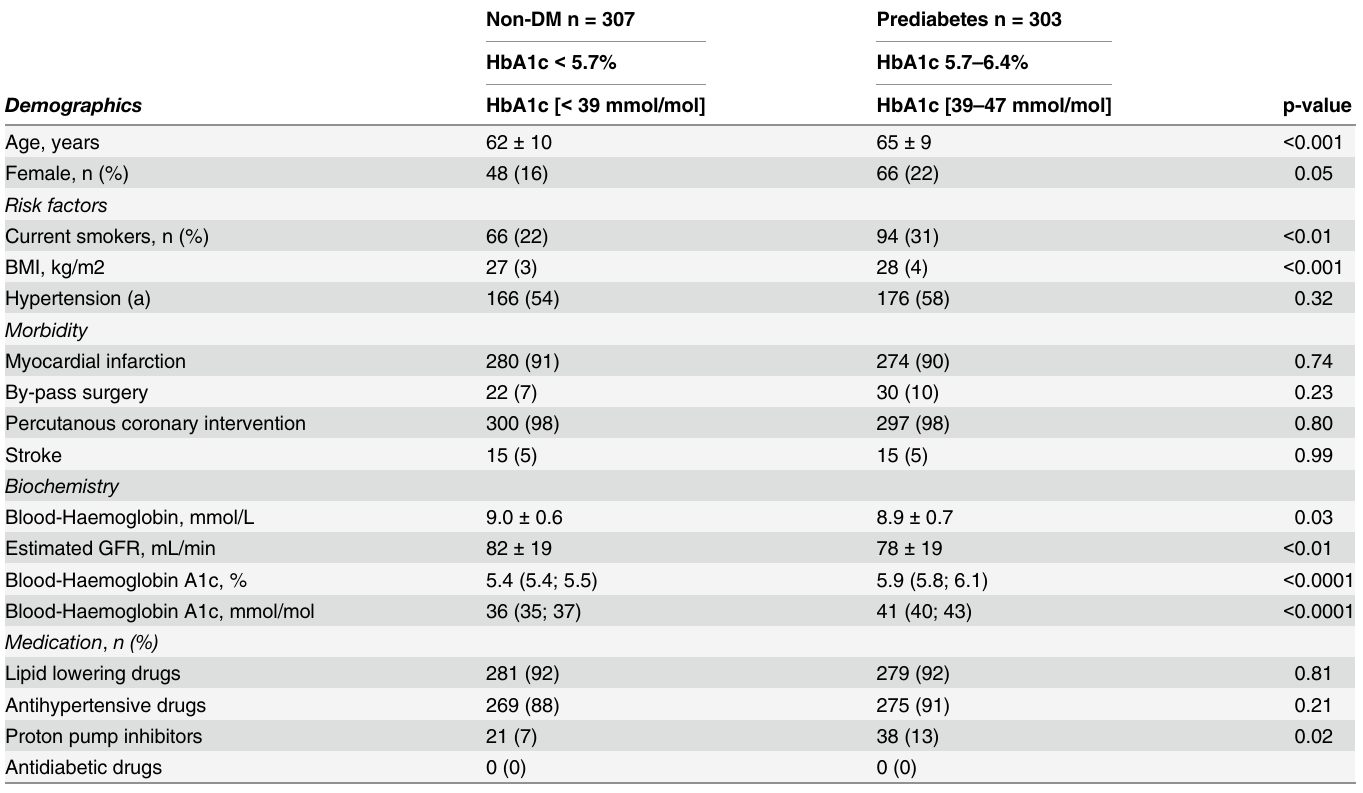
Table 2. Clinical characteristics of coronary artery disease patients with and without prediabetes, n = 620. Non-DM n =